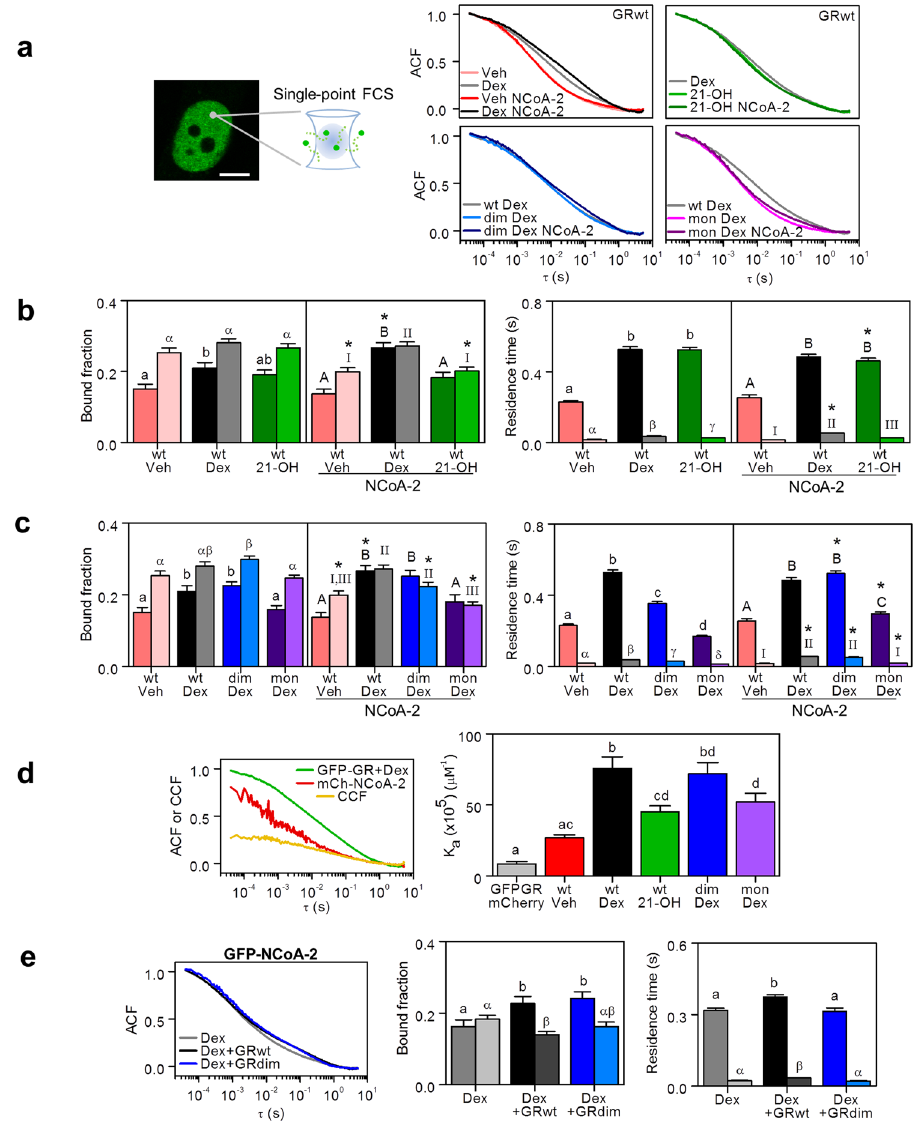
Figure 4. Fluorescence correlation spectroscopy reveals different landscapes of GR/NCoA-2 nuclear interactions. Single-point FCS measurements were run in the nucleoplasm of BHK living cells expressing GFP fused to the wild type GR, GRdim or GRmon and treated with Dex, 21-OH or vehicle (Veh), in the absence or presence of mCherry-NCoA-2. ( a ) Average normalized ACF of the different GFP-GR variants in the specified conditions. ( b , c ) ACF data was fitted with equation (2) to obtain the bound fraction of receptors and residence times engaged in shorter-lived (light colors) and longer-lived (dark colors) interactions (25 < n < 38). Asterisks ( * ) indicate that a parameter significantly differs due to mCherry-NCoA-2 overxpression (p < 0.05). For parameters measured in the absence of mCherry-NCoA-2, lower case (a, b, c) or Greek ( α , β , γ ) letters indicate significant differences among longer- or shorter-lived components, respectively (p < 0.05). For parameters measured in the presence of mCherry-NCoA-2, upper case letters (A, B, C) or Roman numbers (I, II, III) indicate signifcant differences among longer- or shorter-lived components, respectively (p < 0.05). ( d ) The apparent association constant (K a ) between the GFP-tagged receptor (wild type, GRdim or GRmon) and mCherry-NCoA-2 in cells treated with Dex, 21-OH or Veh was calculated from the ACFs and CCF amplitudes (20 < n < 25). Bars with the same superscript letters represent data not significantly different from each other (p < 0.05). Control condition: GFP-GR and mCherry co-expressed in Dex-stimulated cells. Left panel shows the mean, normalized ACFs of GFP-GR and mCherry-NCoA-2 and CCF in cells stimulated with Dex. ( e ) Average normalized ACFs of GFP-NCoA-2 in Dex-stimulated cells, in the absence or presence of mCherry-GR (wild type or GRdim). The ACF data was fitted with equation (2) to obtain the bound fraction of GFP-NCoA-2 engaged in interactions with fixed targets and the shorter-lived (light colors) and longer-lived (dark colors) residence times (22 < n < 43). Lower case ( a , b ) or Greek ( α , β ) letters indicate significant differences among longer- or shorter-lived components, respectively (p <